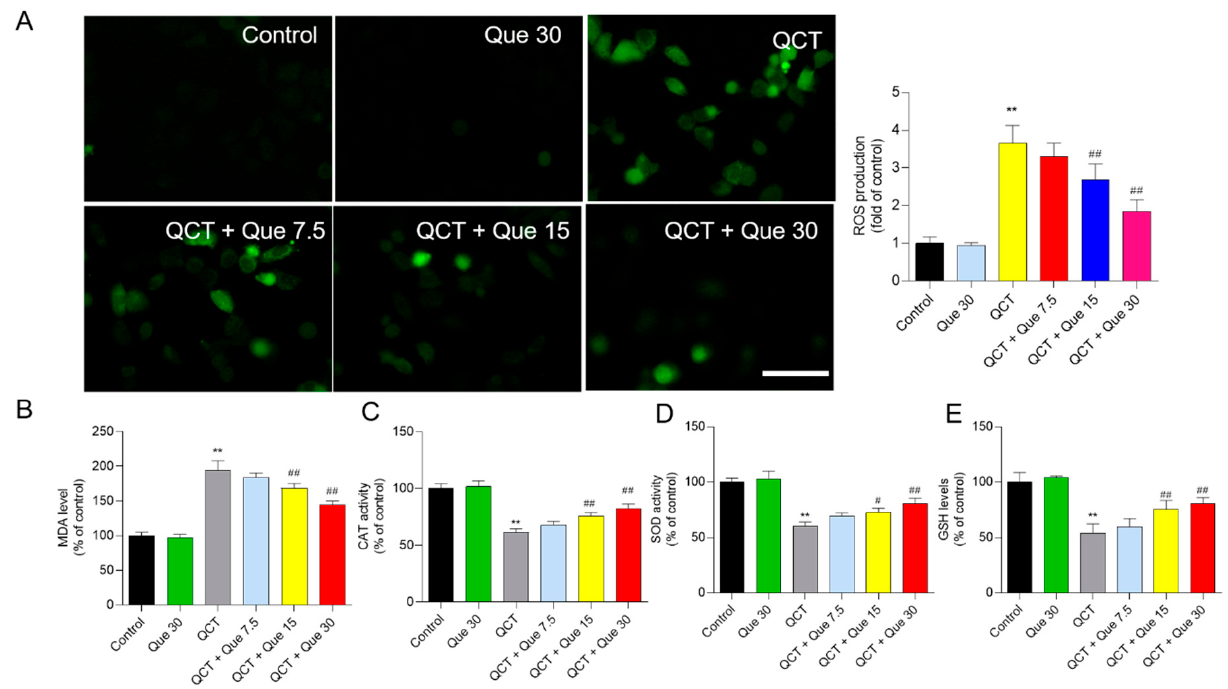
Figure 4. The effect of quercetin supplementation on QCT-induced ROS production and oxidative damage in human L02 cells. ( A ), Measurement of ROS production. Intracellular ROS production was measured using the dye 2,7-dichlorofluorescein diacetate staining. The representative images were shown (on the left) and the fluorescence intensities were quantified using Image J (on the right). Bar = 50 µ m. ( B – E ), The effect of quercetin supplementation on MDA levels ( B ), catalase (CAT) activity ( C ), superoxide dismutase (SOD) activity ( D ), and glutathione (GSH) levels ( E ) were measured, respectively. All results were presented as mean ± SD ( n = 4 independent experiments). ** p < 0.01, compared to the vehicle control group; # p < 0.05, and ## p < 0.01, compared to the QCT-alone group. QCT, quinocetone; Que, quercetin; Bar = 50 µ